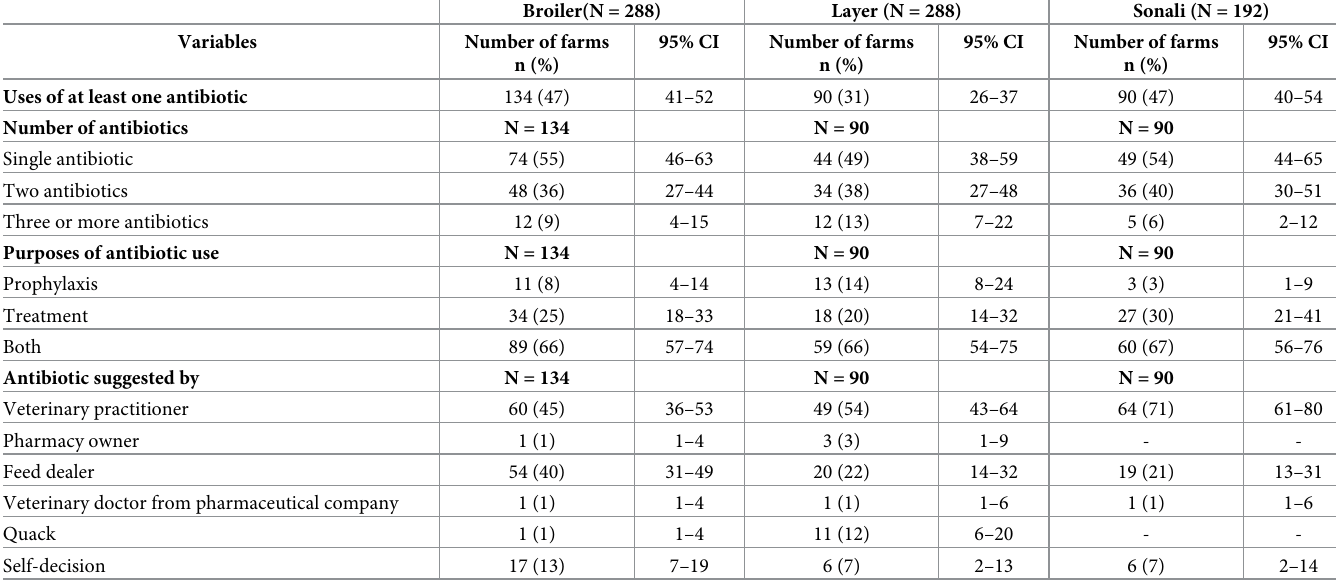
Table 2. Farm-level antibiotic use within the 24 hours preceding visits to commercial broiler, layer and Sonali chicken farms in Bangladesh during January-May 2021.